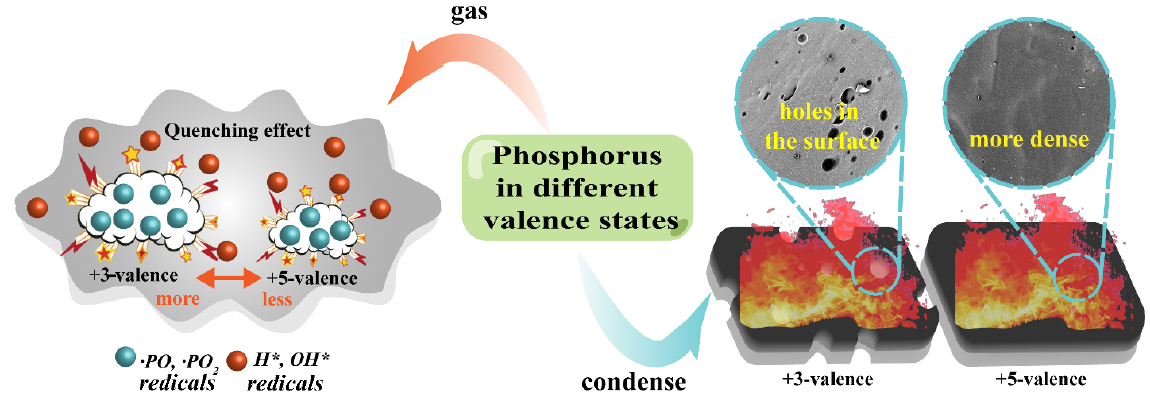
Figure 8. The flame-retardant mechanism of phosphorus in different valence states.